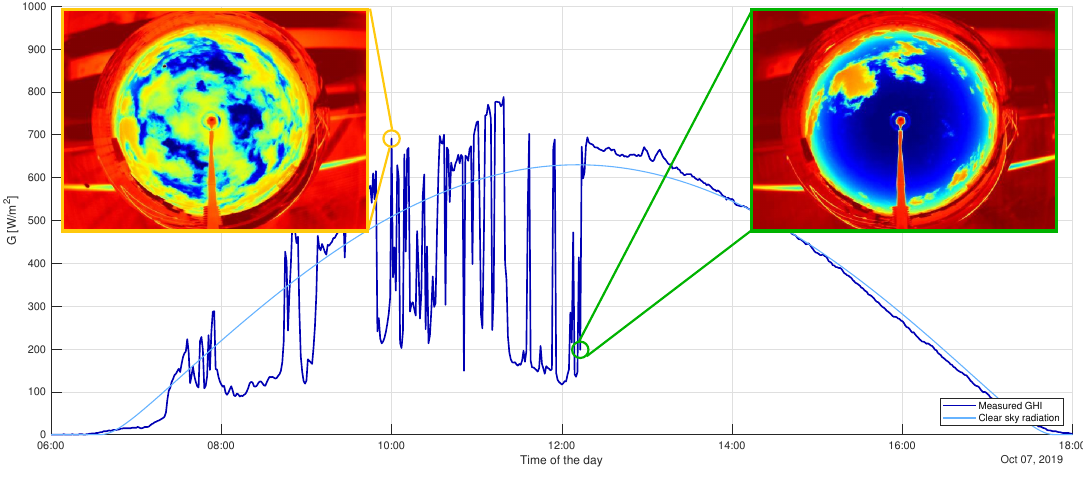
Figure 6. Cloud effect on irradiation measurements.